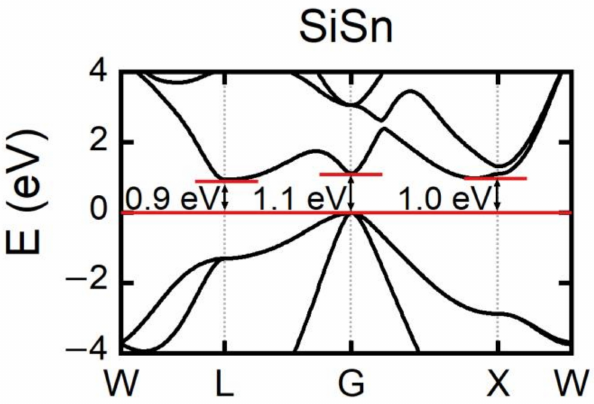
Figure 2. The band structures of CSn, SiGe, and SiSn from GW approximation.